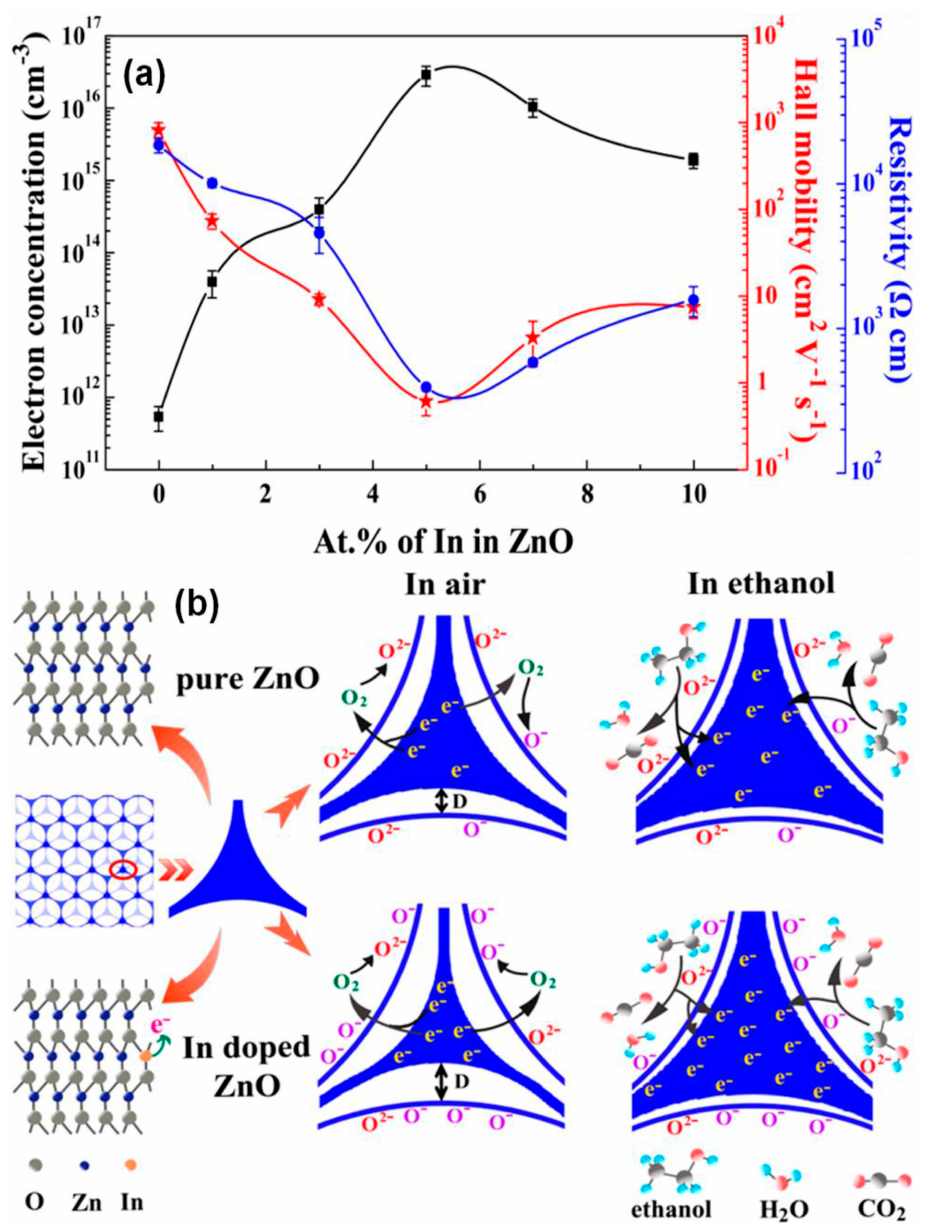
Figure 10. ( a ) Electron carrier concentration, resistivity, and Hall mobility of the 3 dimentional macroporous structures; the error bars represent the SD of the determinations for three independent samples; ( b ) Schematic diagram of ethanol sensing on the surface of pure and In-doped 3DOM ZnO. Adapted figure from [85] with permission from copyright (2016), American Chemical Society, (Washington, DC, USA).